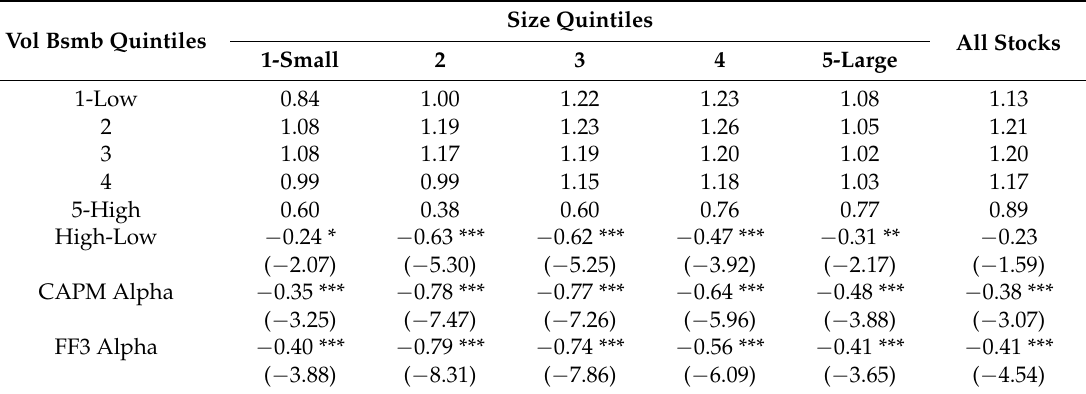
Table 4. Sort by Size and